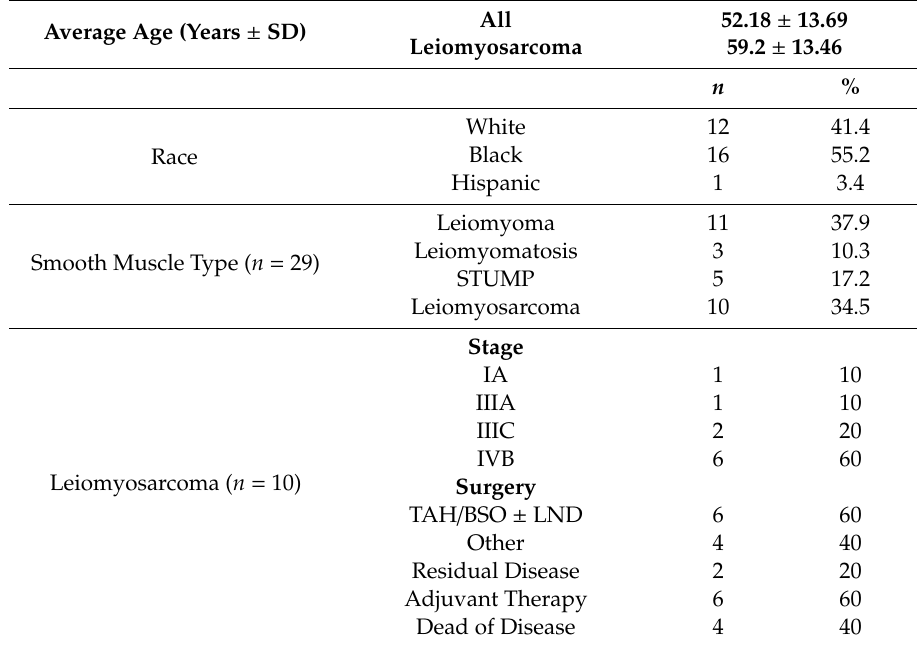
Table 2. Patient Clinical